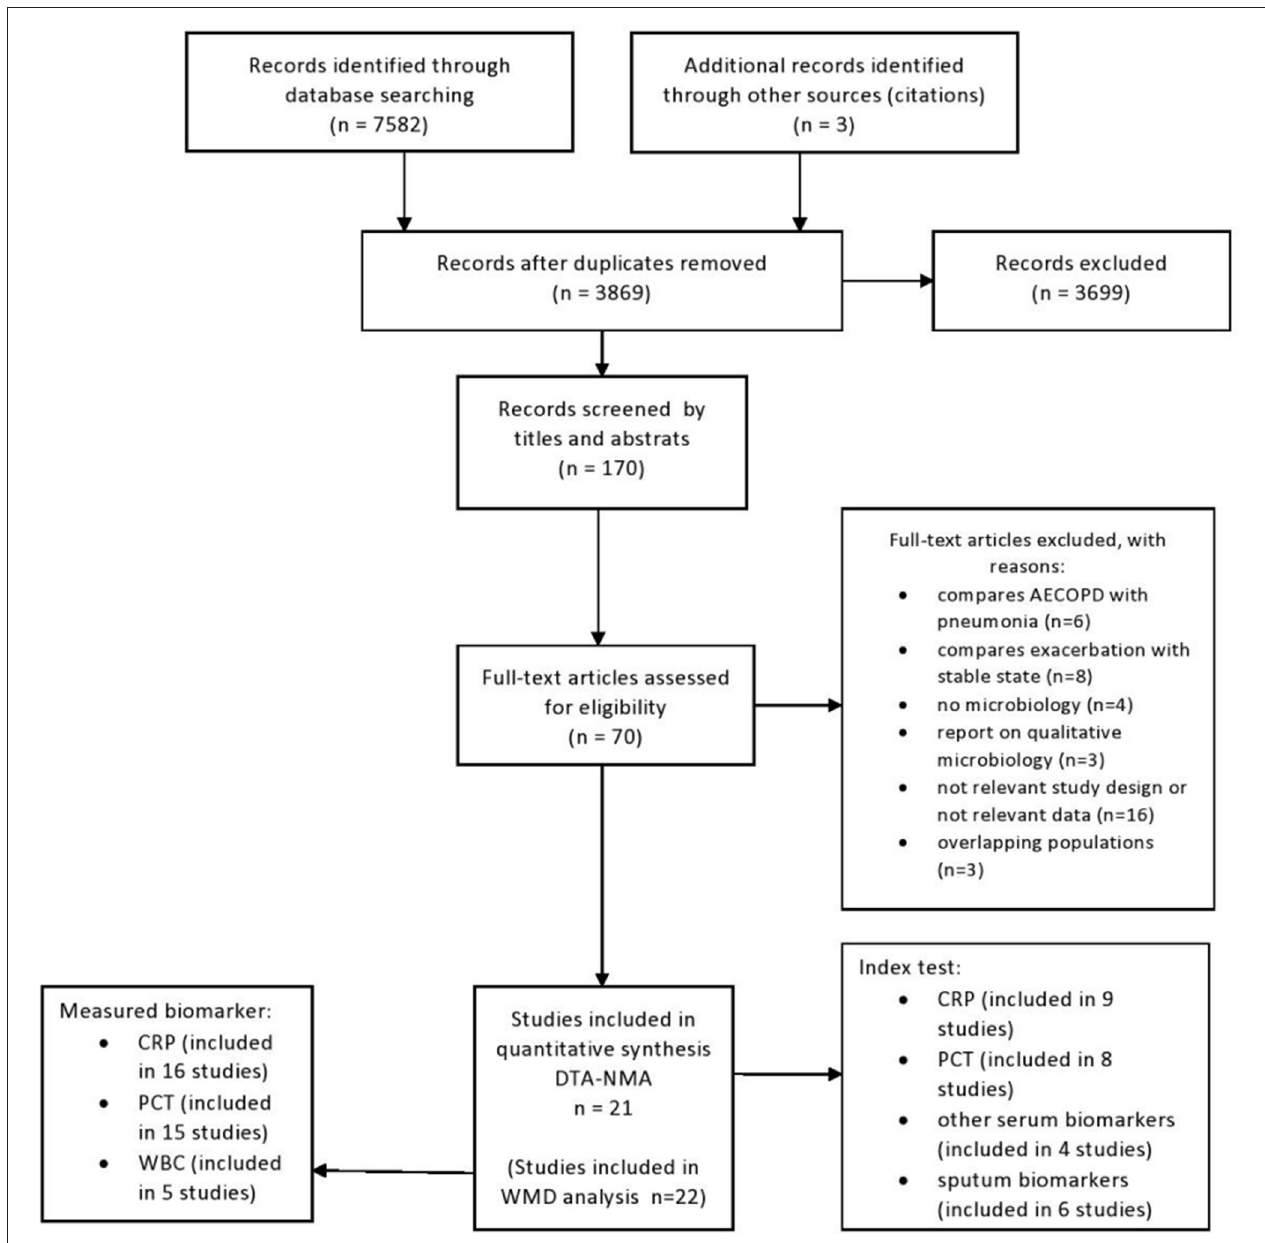
FIGURE 1 | PRISMA flowchart of systematic search and